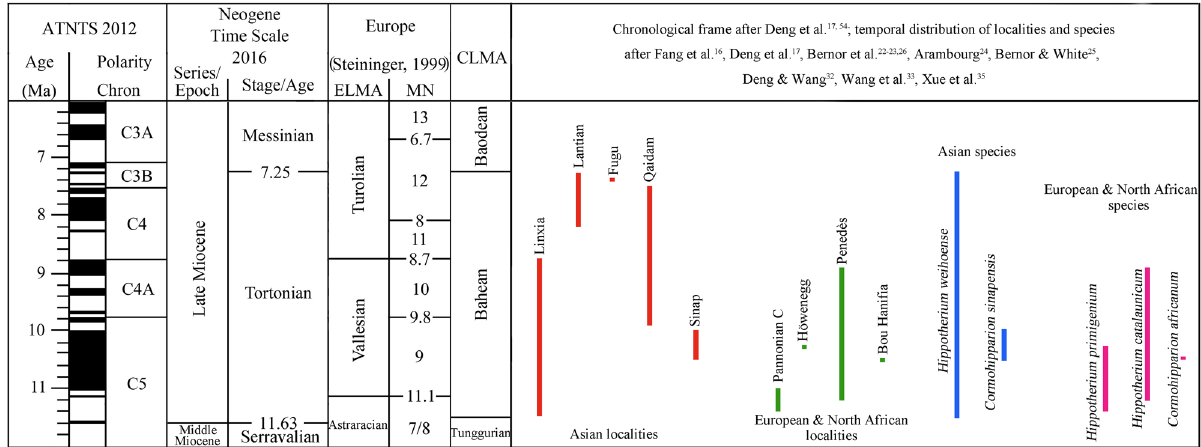
Figure 5. Localities and species of Hippotherium and Cormohipparion and their temporal distribution in Old World (generated with Adobe Photoshop version CS 6 by B.